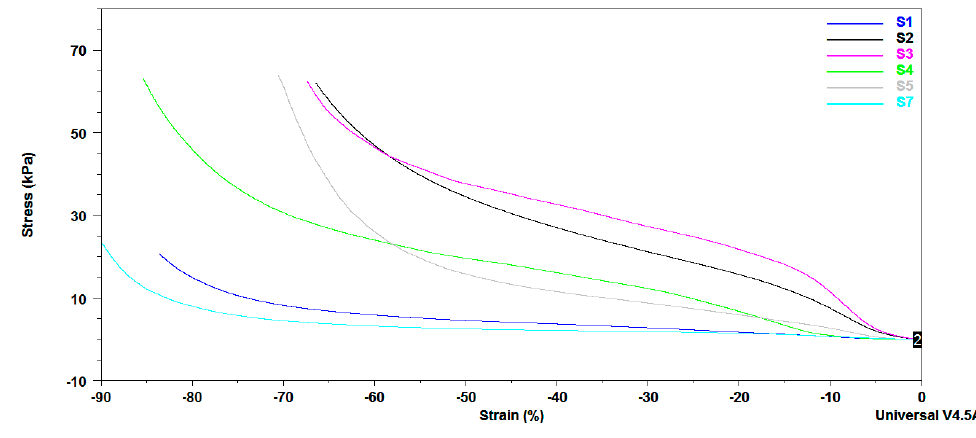
Figure 6. DMA stress–strain curves obtained for the crosslinked salecan samples swollen in deionized water at equilibrium.